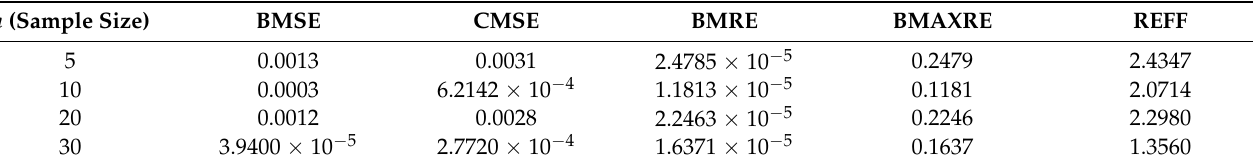
Table 9. Robustness: numerical results for case C1.